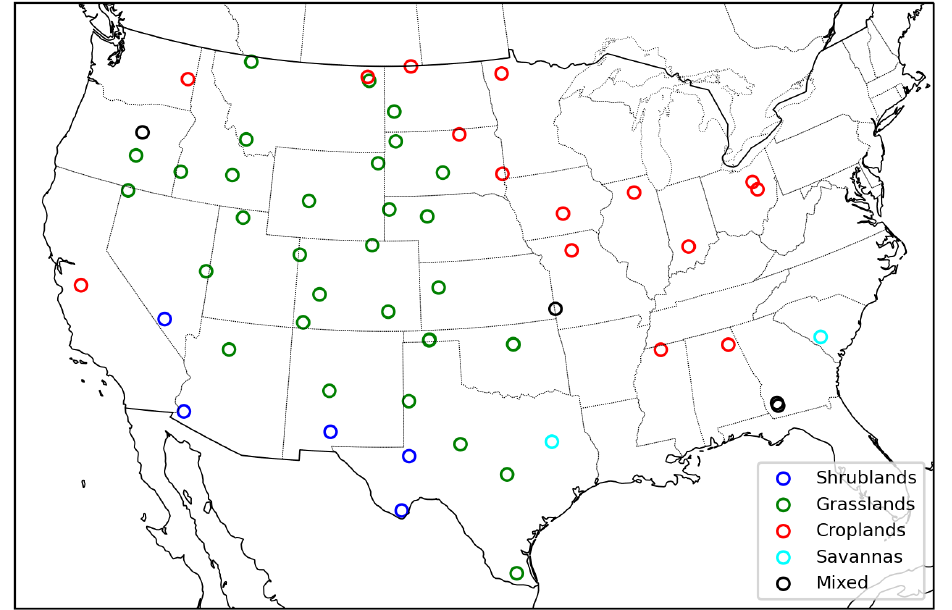
Figure 1. Spatial distribution of selected USCRN stations classified by land